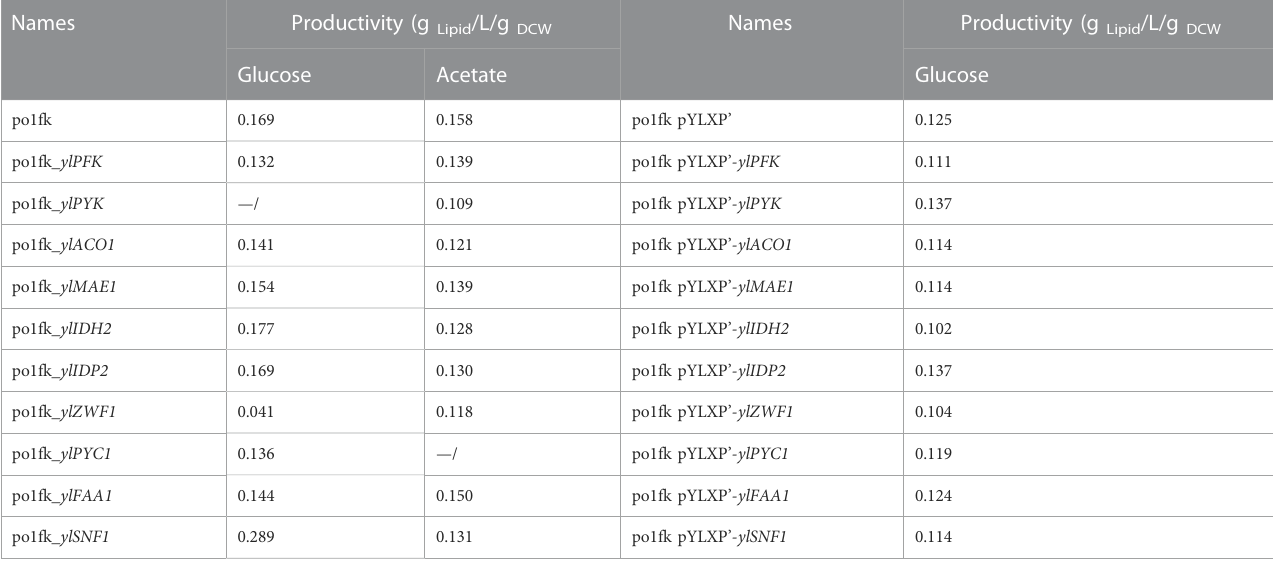
TABLE 2 The productivity of engineering strains in the different cultivations.